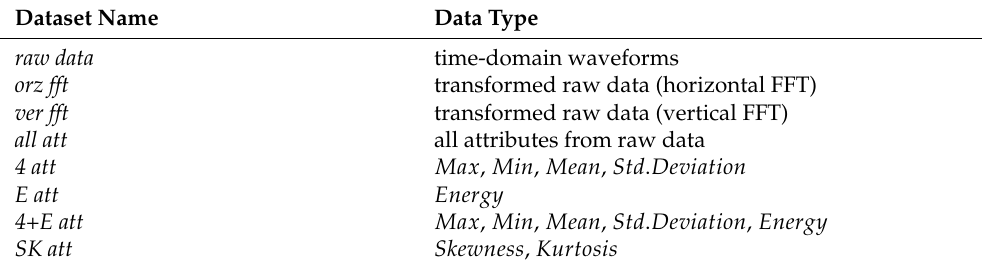
Table 3. Datasets legend.